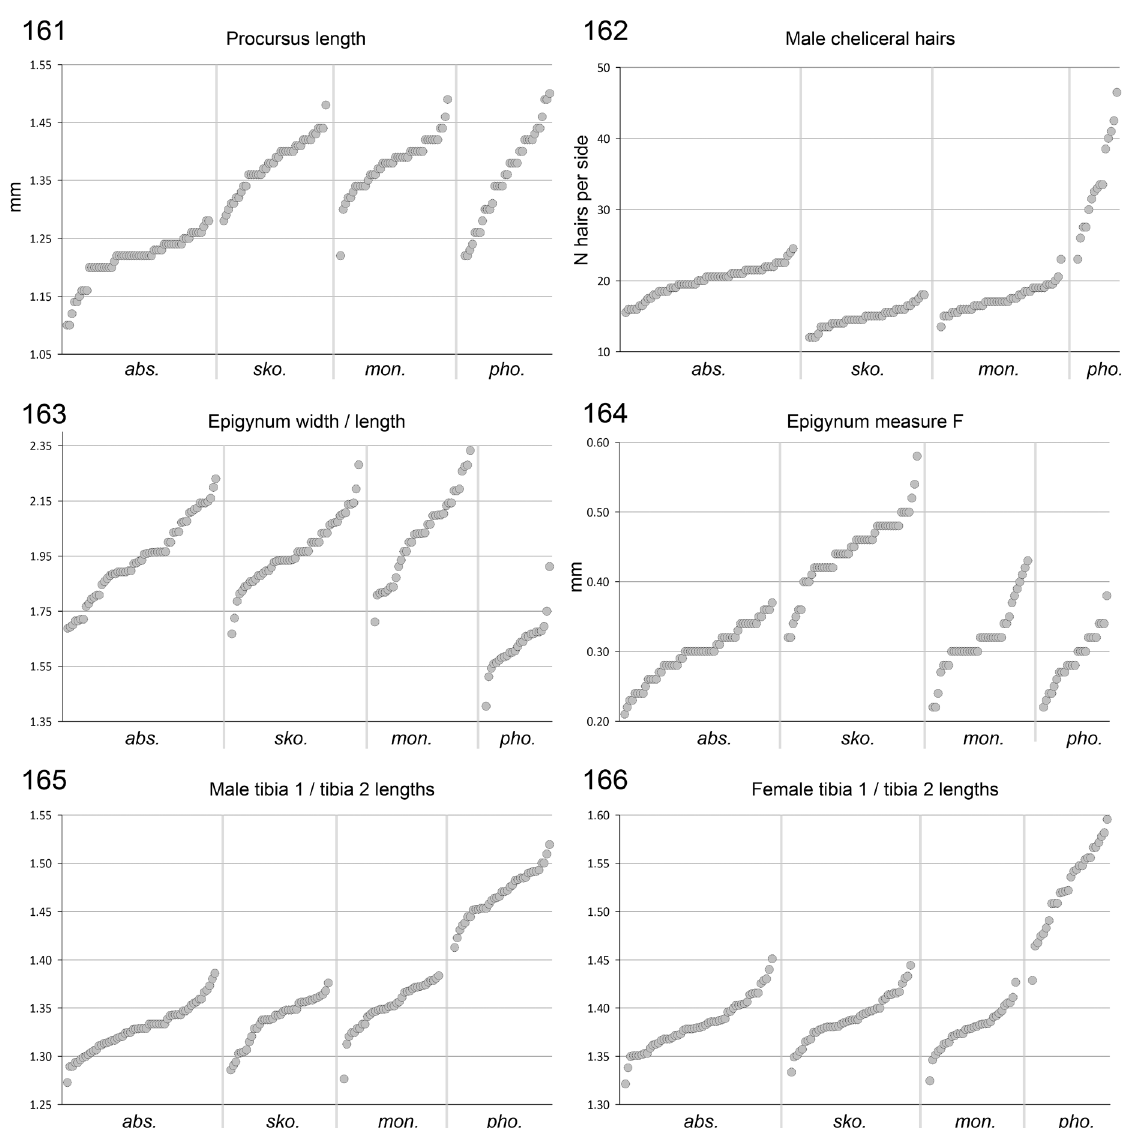
Figs 161–166. Procursus length, number of modified hairs on each male chelicera, epigynum width/ length, epigynum measure F (cf. Fig. 21), and relationships between tibia 1 and tibia 2 lengths in males and females. Measures/counts sorted from smallest to biggest for each species. Abbreviations: abs . = S. absoloni ; sko . = S. skotophilus ; mon . = S. montenegrinus ; pho . = S. photophilus